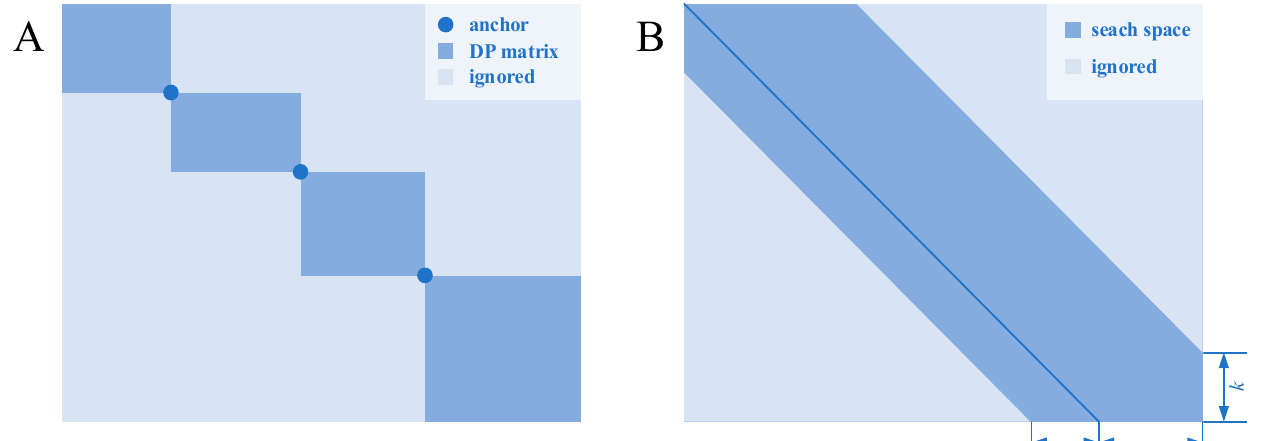
Figure 1. Two heuristic algorithms for pairwise sequence alignment. ( A ) A dynamic programming matrix, which is separated by several anchors, which is certain to be in the optimal path. ( B ) A shape-based bounded dynamic programming matrix in which the light blue block is calculation-free because these states are thought to be less likely to be in the optimal path.